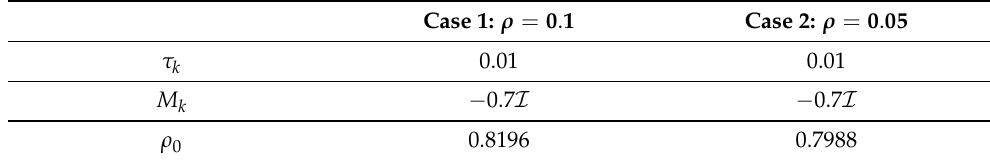
Table 1. Comparison of the influence from different impulse frequencies when other data are unchanged. Case 1: ρ = 0 .